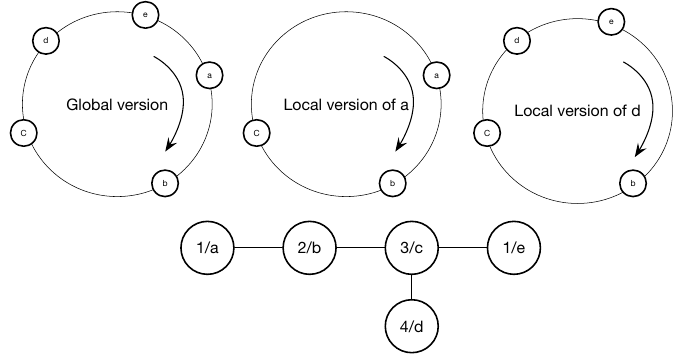
Figure 3. An example